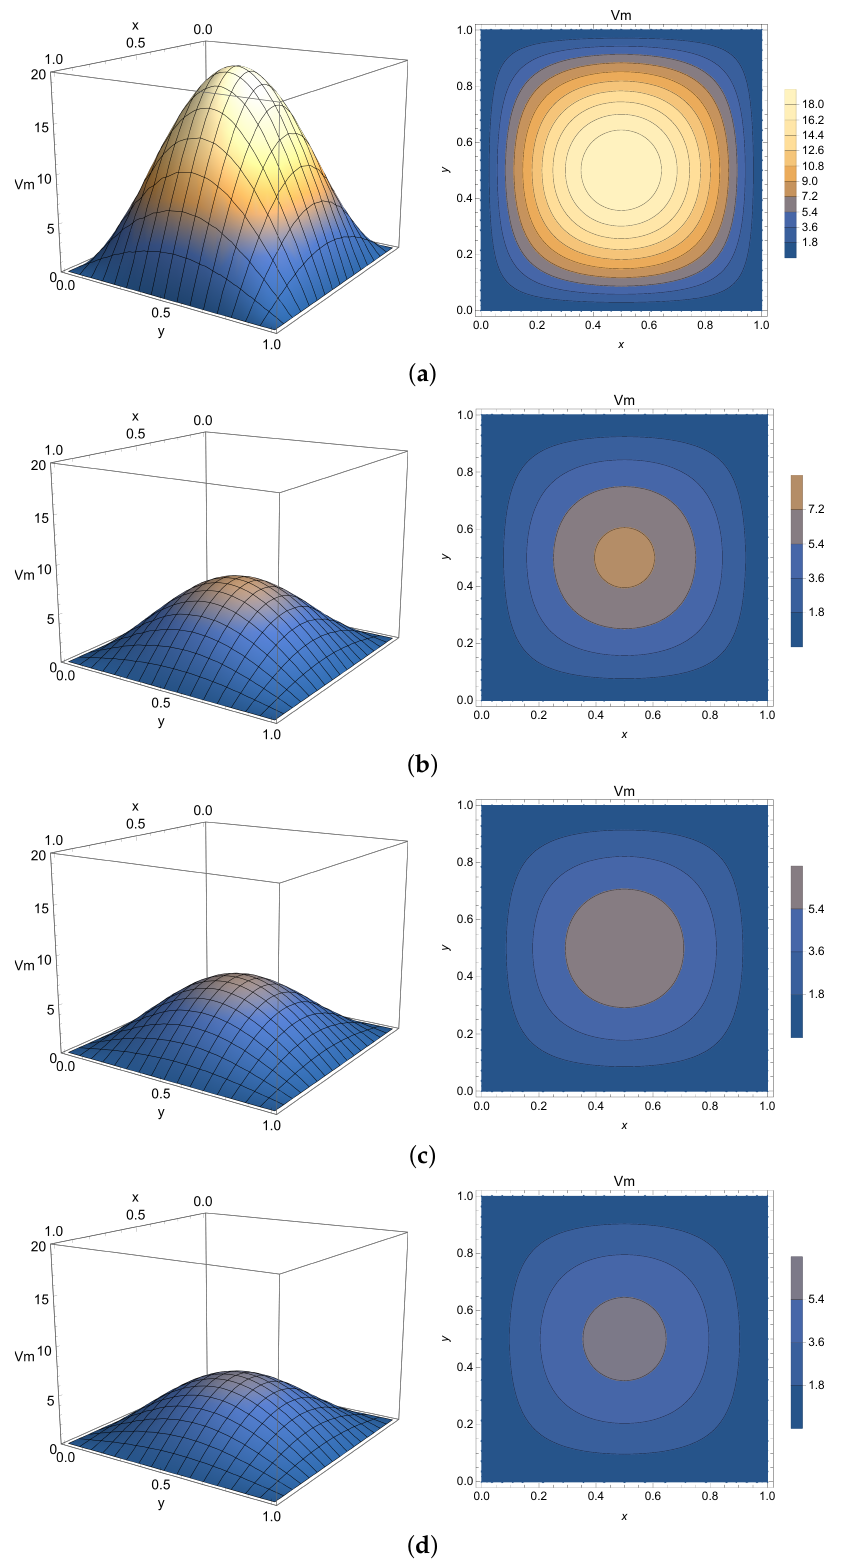
Figure 10. Two-dimensional homogeneous solution describing the potential plateau after depolariza- tion: Equation (27) with α = 0.25. ( a ) t = 0 µ s, ( b ) t = 250 µ s, ( c ) t = 500 µ s, ( d ) t = 1000 µ